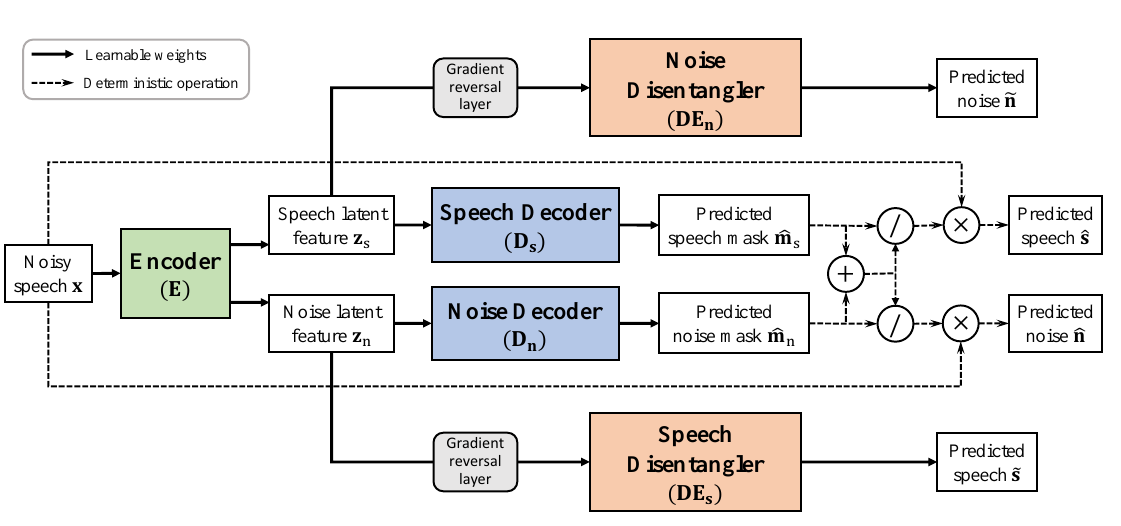
Figure 1. The architecture of the proposed model for disentangled feature